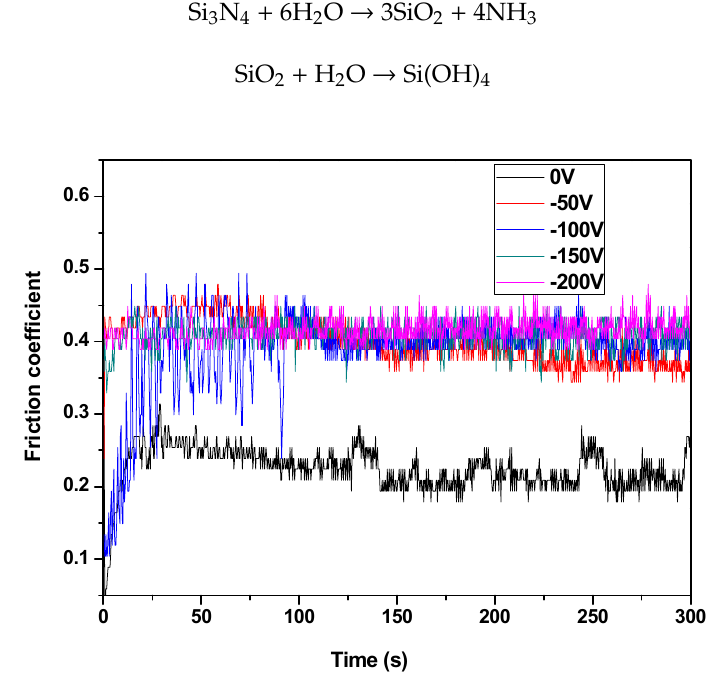
ffi cient of Cr–Si–N coatings deposited under di ff erent bias Figure 8. Friction coefficient of Cr–Si–N coatings deposited under different bias voltages. Figure 8. Friction coe